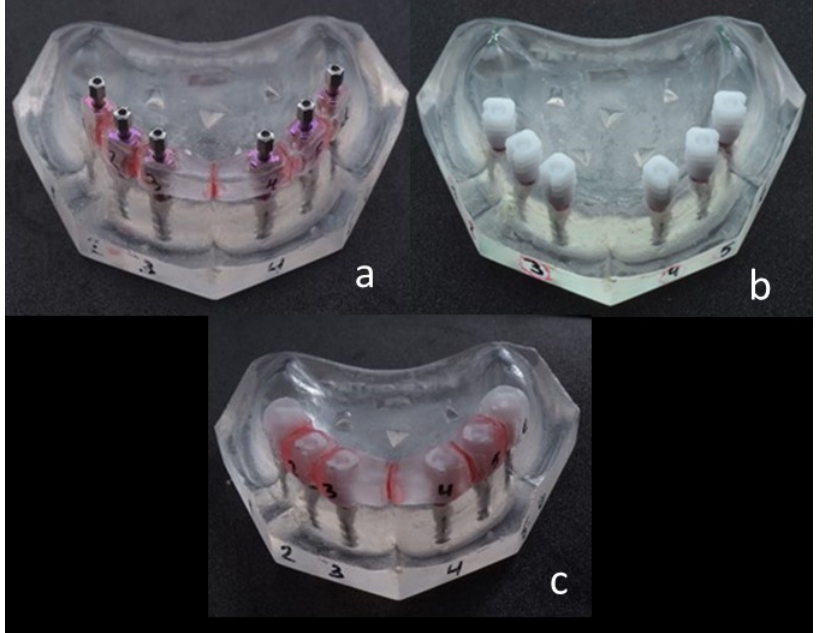
Figure 2. Study groups: a —direct impression group (DI); b —indirect snap on impression group (SpO); c —indirect connected snap on impression group (SpOC) .